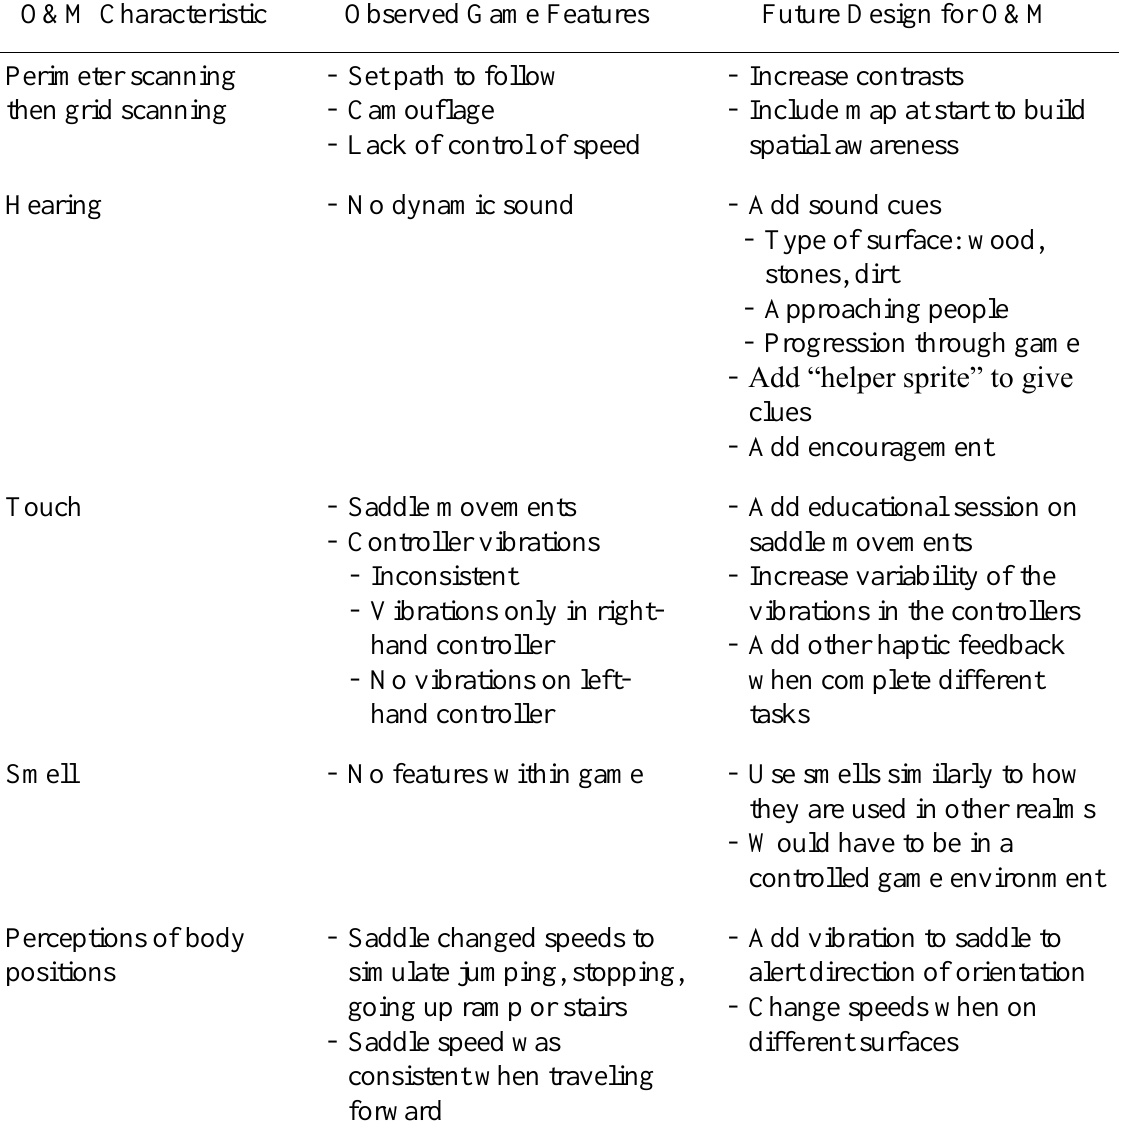
Table 1. Description of Observed Game Features and Recommendations for Future Design for O&M by O&M